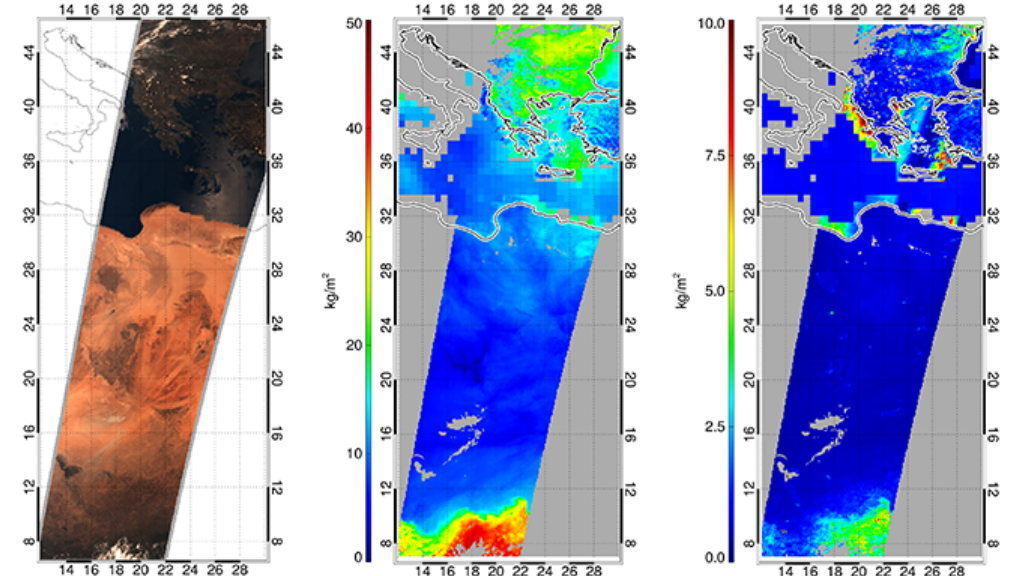
Figure 2. MERIS RGB image of scene over the Mediterranean Sea from 2 May 2003 (left) and close-up of daily composite of TCWV (middle) and uncertainty of TCWV (right) from MERIS and SSM/I